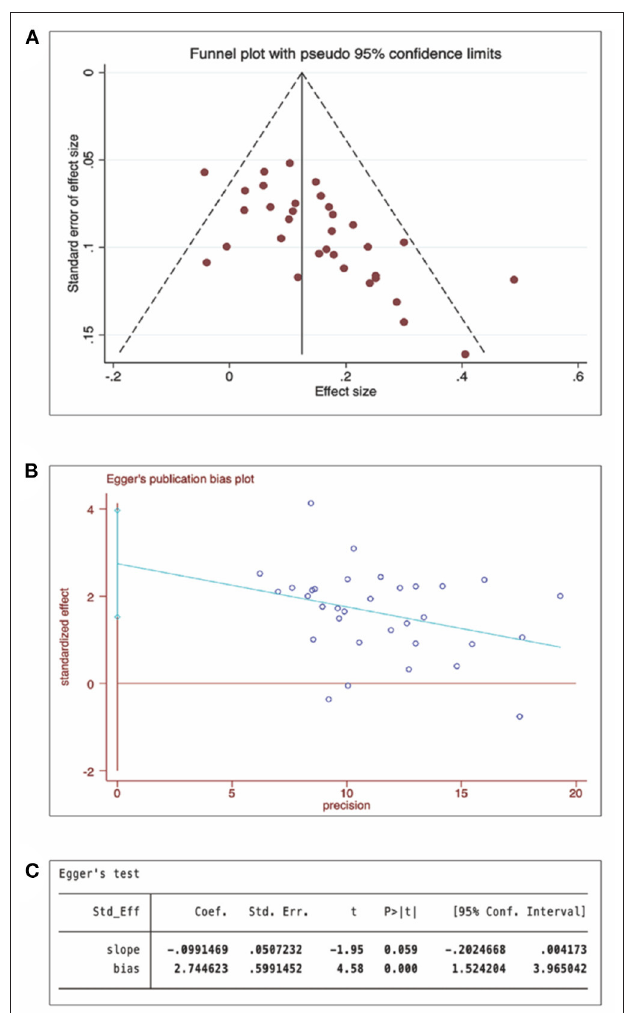
FIGURE 4 | Publication bias of total effectiveness rate (moxibustion for KOA). (A) Funnel plot, (B) Egger’s test, and (C) Egger’s test P-